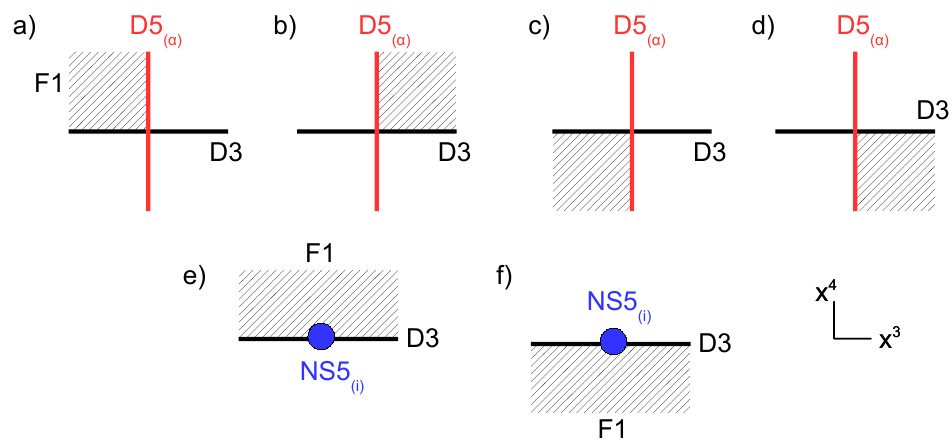
Figure 36 . Setups inserting hyper-multiplet scalar operators. The insertions are: a) Q a , b) e Q a , c) (cid:0) e Q a , d) Q a , e) q i , f) (cid:0) q i e